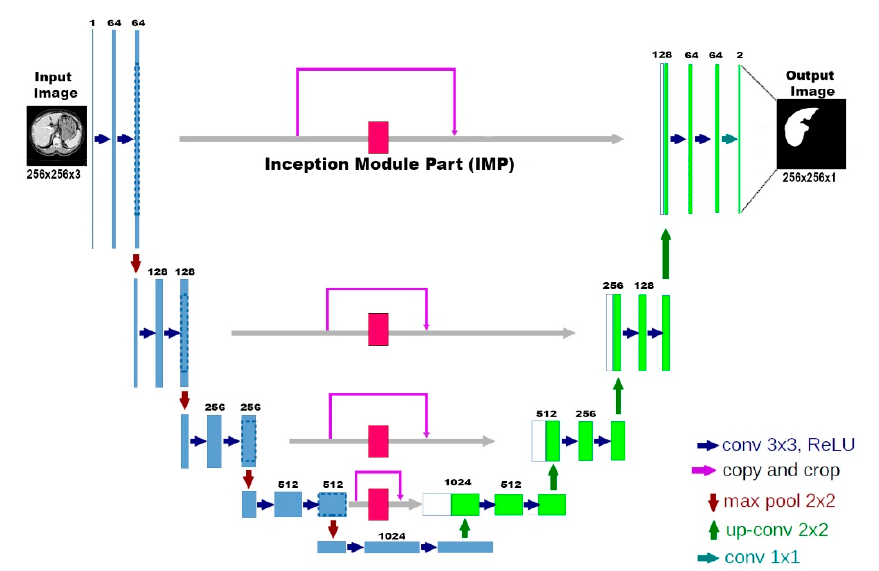
Figure 2. AIM-Unet architecture .